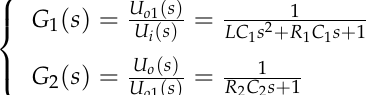
U after ADC sampling and keeping the front end. 1 o